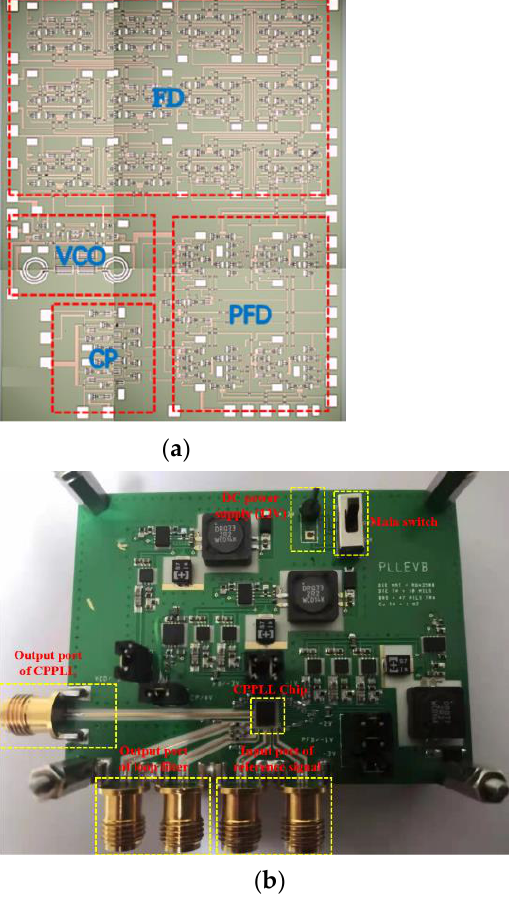
Figure 10. ( a ) Micrograph of the proposed CPPLL; ( b ) the test board.